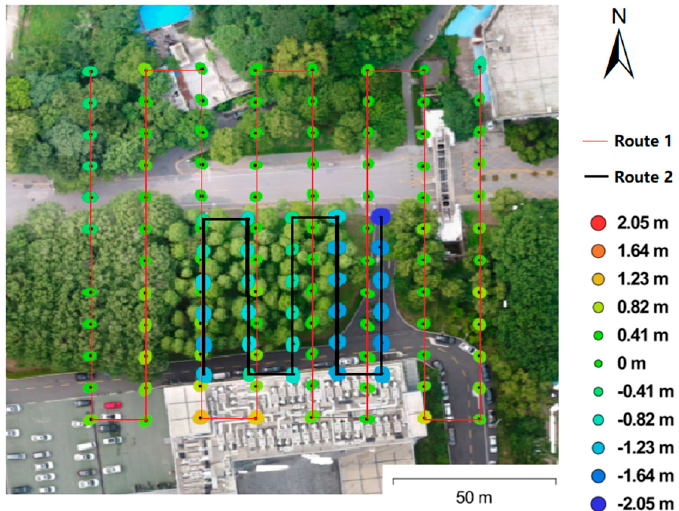
Figure 4. UAV flight routes and error estimates. Z error is represented by ellipse color. X, Y errors are represented by ellipse shape. The estimated camera locations are marked with a black dot and the flight routes are the connection of these dots.